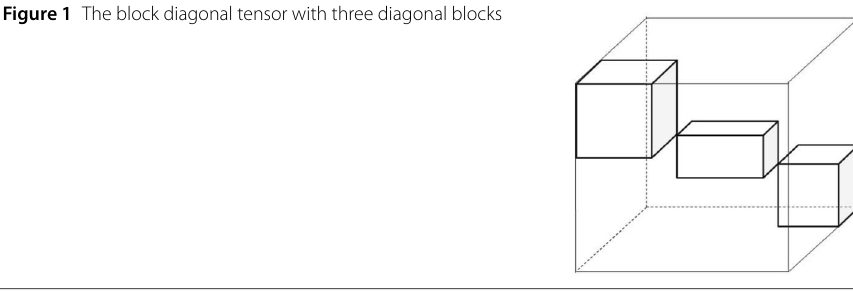
Figure 1 The block diagonal tensor with three diagonal